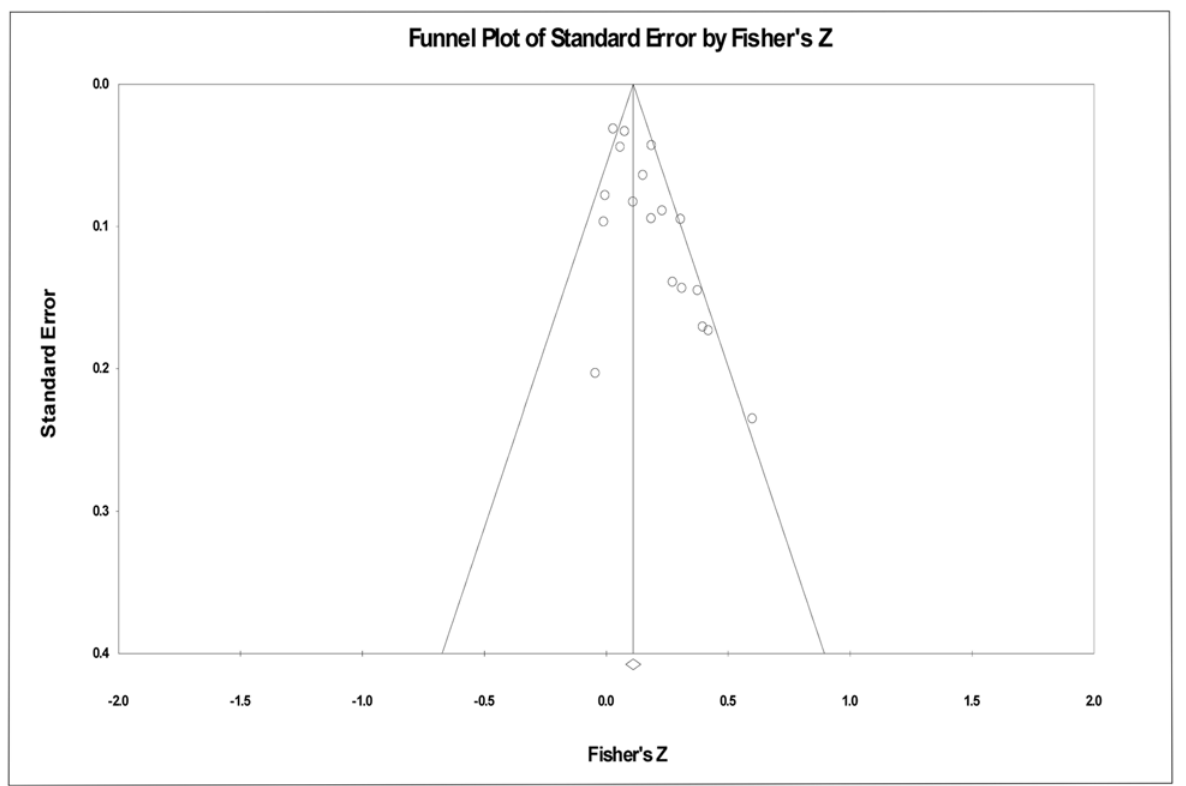
Fig 2. Funnel plot. Funnel plot of Z-transformed effect sizes, plotted against their standard